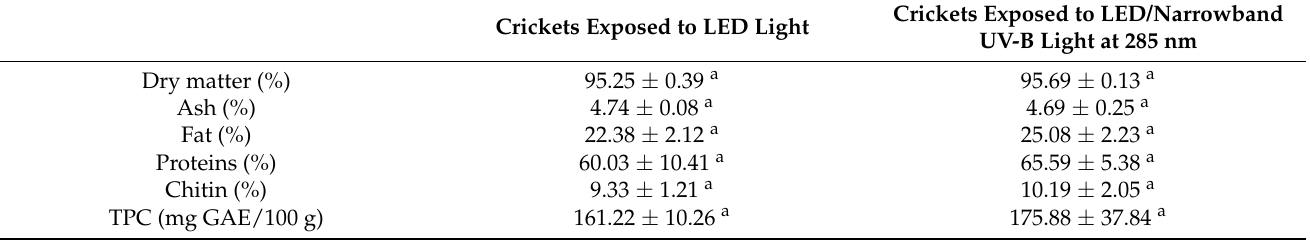
Table 3. Composition analysis of the Acheta domestica that were exposed to the two irradiation regimes. Results are expressed as a percentage of dry